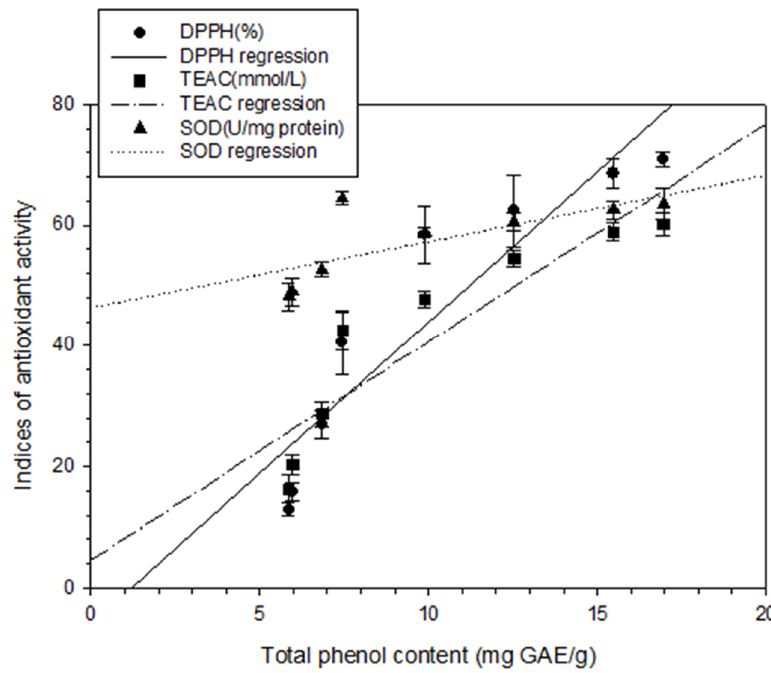
Figure 3. Correlation between DPPH scavenging capability (%), TEAC (mmol/L) and SOD (U/mg protein) and between total phenolic content (mg GAE/g). Each test was performed in triplicate, and results are expressed as the average of three measurements ± standard deviation. The scale of error bar is too small to be